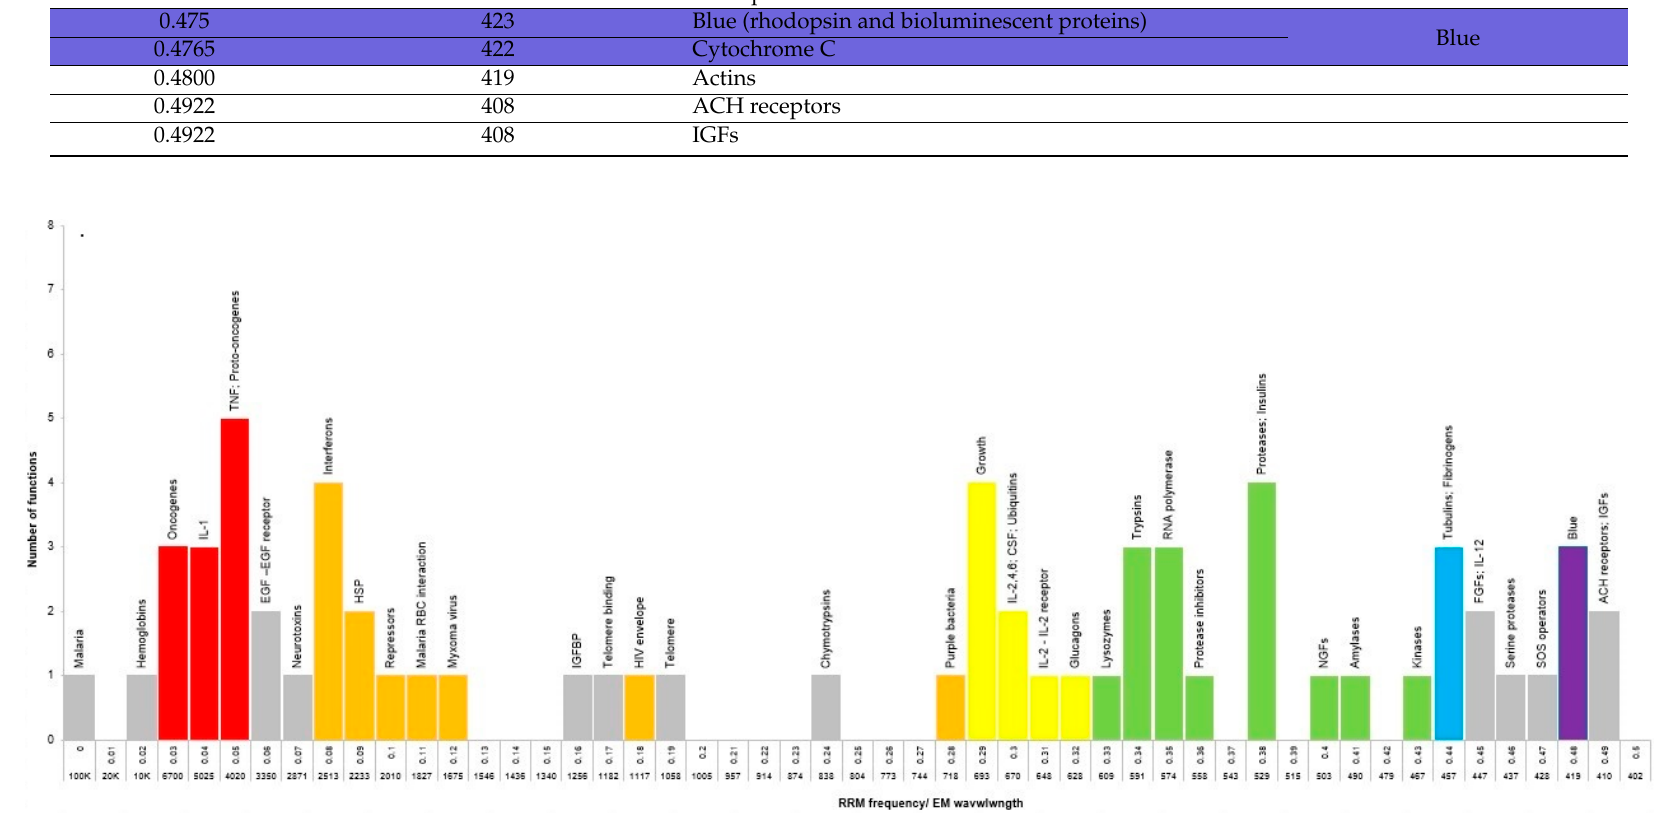
Figure 1. Number of functional groups within each Resonant Recognition Model (RRM) frequency range of 0.01. X axis represent RRM frequency in steps of 0.01, as well as corresponding electromagnetic frequency in nm. Y axis represent number of functional groups. Names of functional groups are noted above each bar. Super families are colored as in Table 1.